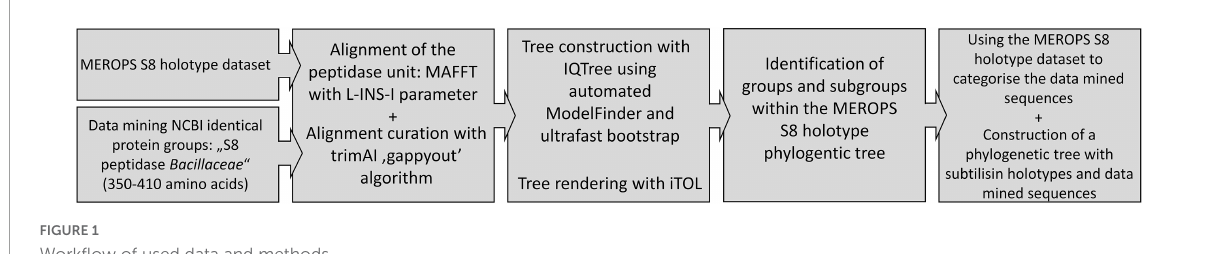
FIGURE1 Workflow of used data and